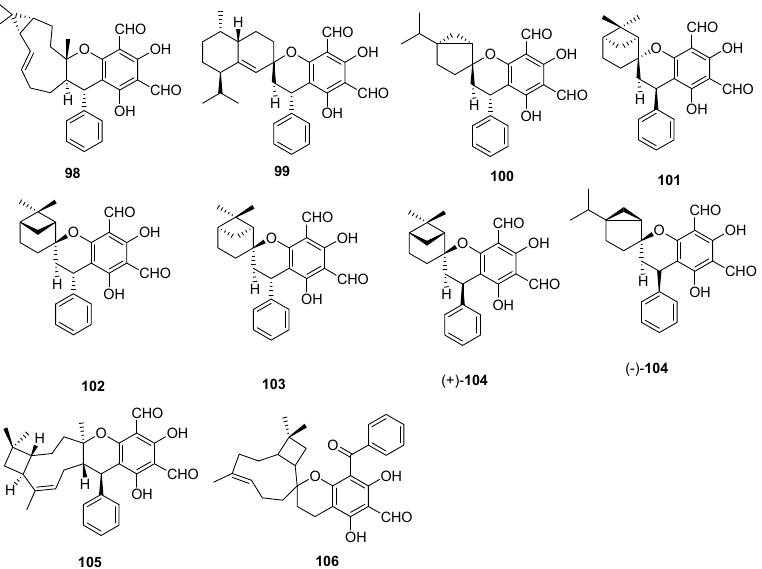
Figure 8. Meroterpenoids isolated from P. guajava L.